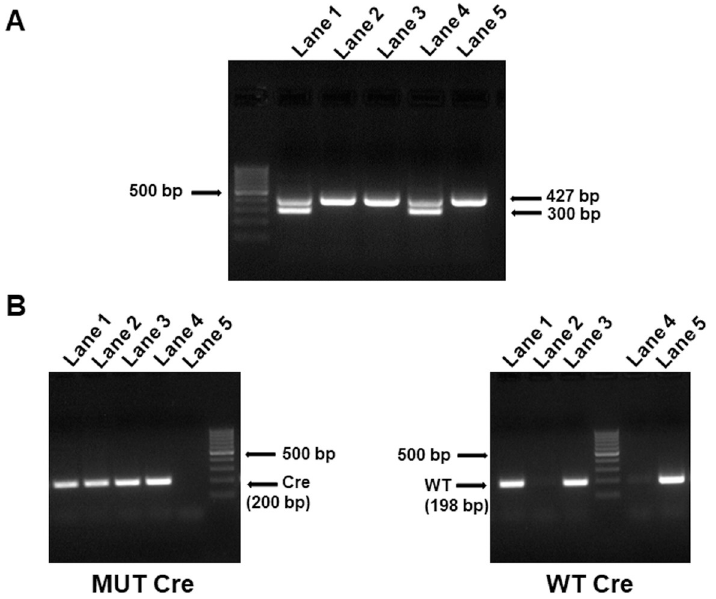
Fig 5. Floxed E8 and tamoxifen inducible Cre recombinase in Hlcs tm1 . 1Jze mice. (A) Pups homozygous for floxed E8 (lanes 2, 3 and 5) and heterozygous for floxed E8 (lanes 1 and 4) were identified by PCR. (B) Pups homozygous for Cre recombinase (lanes 2 and 4) and heterozygous for Cre recombinase (lanes 1, 3 and 5) were identified by PCR. Lanes with the same labels represent DNA from the same mouse across the gels shown. MUT Cre, mutant Cre recombinase allele; WT Cre, wild-type Cre recombinase